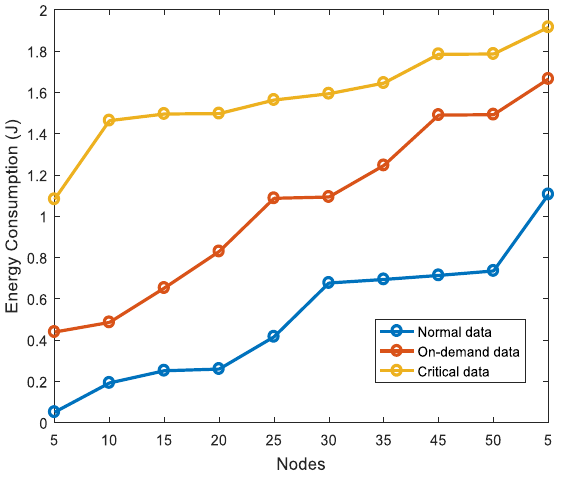
Figure 4. Energy